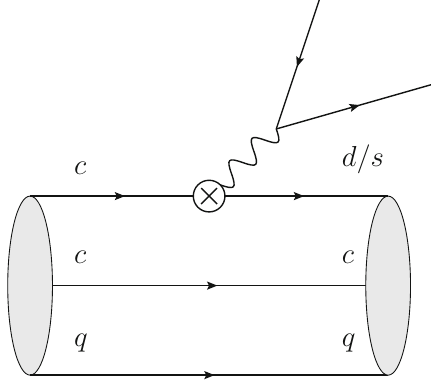
Fig. 2 The Feynman diagrams for the semileptonic decays of (cid:2) cc and (cid:5) cc Table 2 SU(3) amplitudes for doubly charmed baryons (cid:2) cc and (cid:5) cc decays into a singly charmed baryon Channel Amplitude Channel